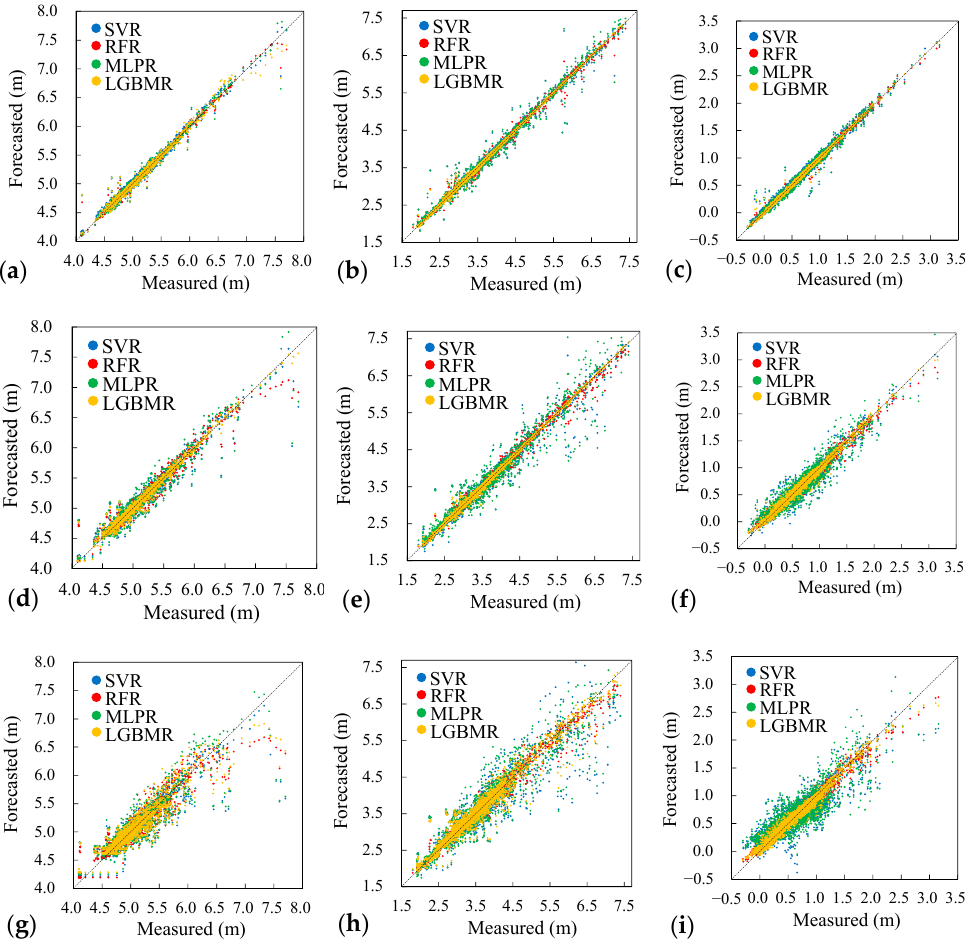
Figure 7. The Scatter plots of measured river stage against forecasted river stage using four models for 1-h lead time at ( a ) Simon ( b ) Lanyan ( c ) Kavalan stations, for 3-h lead time at ( d ) Simon ( e ) Lanyan ( f ) Kavalan stations, and for 6-h lead time at ( g ) Simon ( h ) Lanyan ( i ) Kavalan stations.